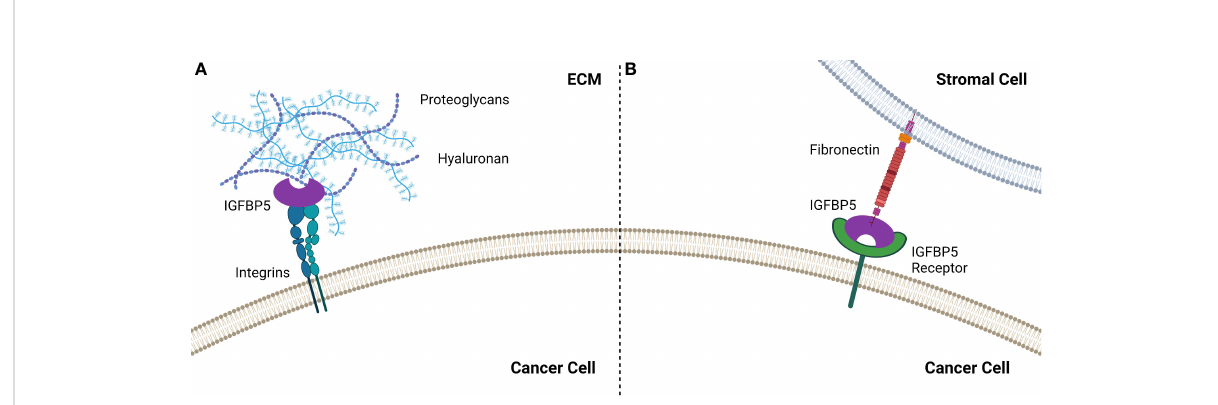
FIGURE 3 IGFBP5 interacts with the extracellular environment to enable cell attachment by (A) binding to integrins which enable attachment via the HBD or (B) by interacting with fi bronectin the TME, most likely via an unidenti fi ed IGFBP5 receptor.